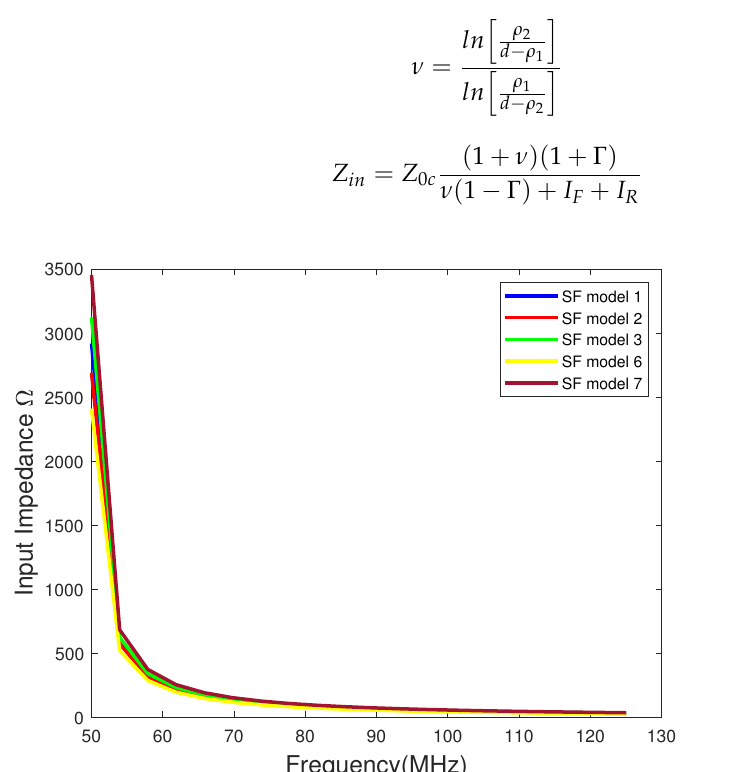
Figure 18. Input impedance of single-fold (SF) antenna models with respect to frequency calculated from Equation (4). Numerically SF models 4 and 5 will show similar characteristic impedance as SF model 1.